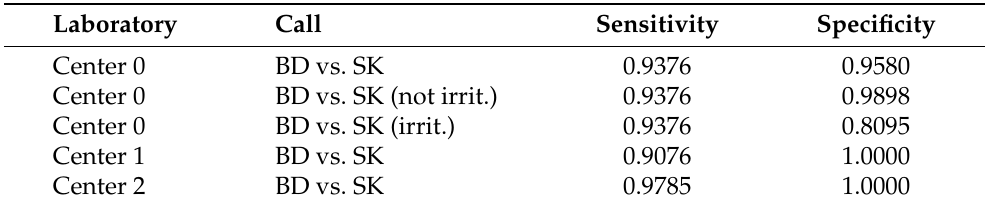
Table 6. Test scores for differentiating BD from SK using the relative area approach.